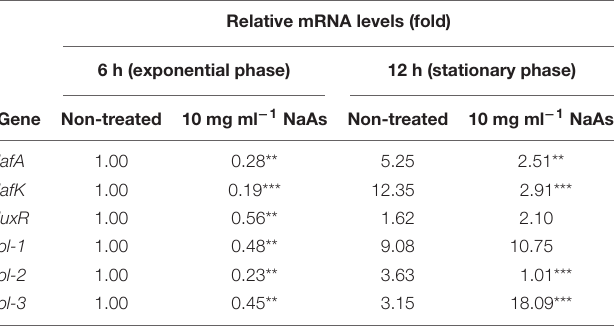
Average standard deviation of three independent cultures, ∗∗ in the graph indicates P < 0.01 and ∗∗∗ indicates P < 0.001 (One-way ANOVA with